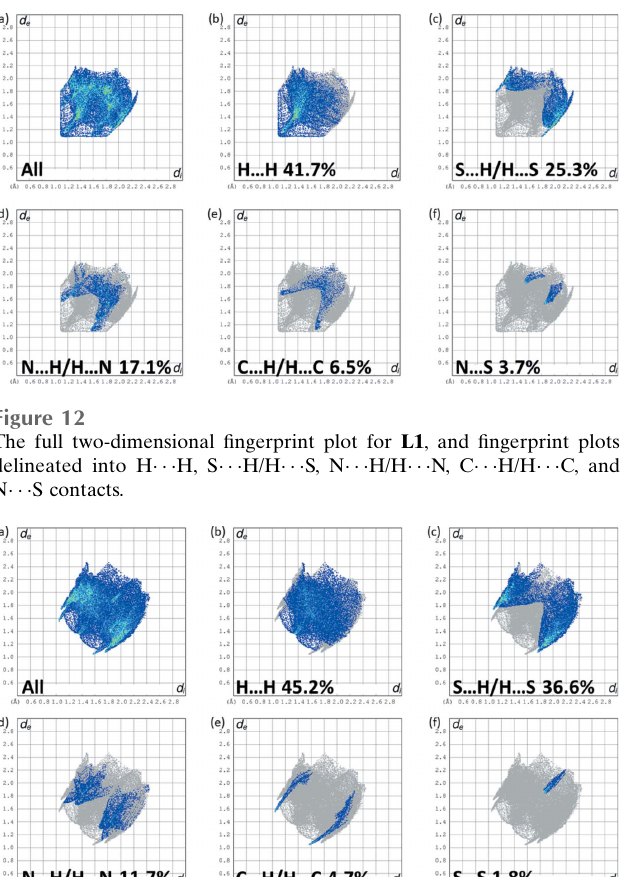
d , and in Table 5. In Fig. 13 e the sharp spikes at d norm 2.6 A˚ indicate the significant contribution of the C (cid:2) (cid:2) (cid:2) H/H (cid:2) (cid:2) (cid:2) C contacts in the crystal of L2 .